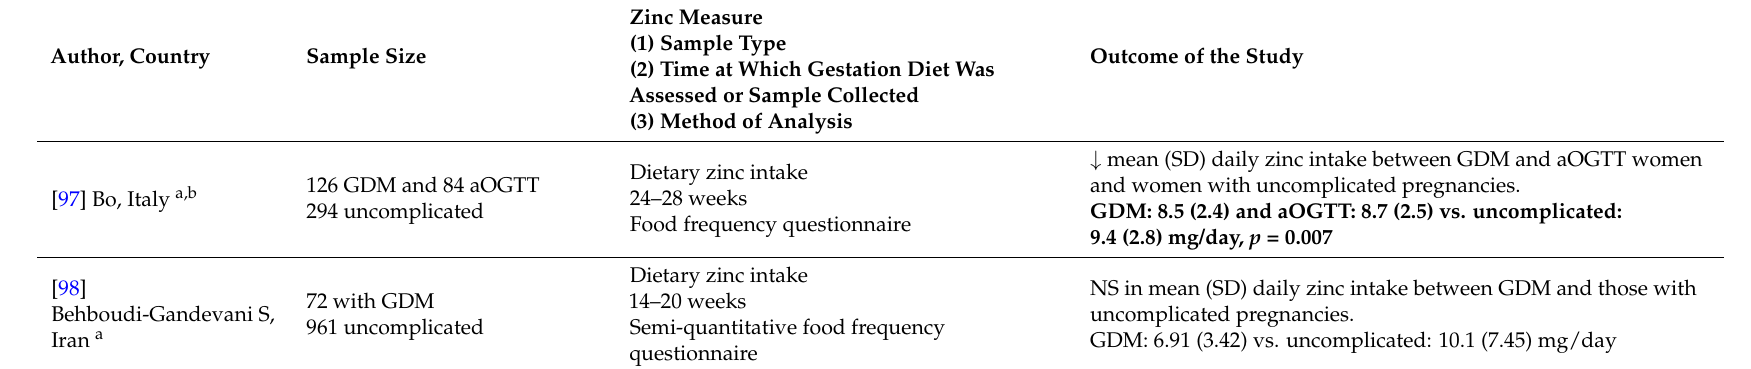
Table 4. Included studies assessing maternal zinc status and GDM.